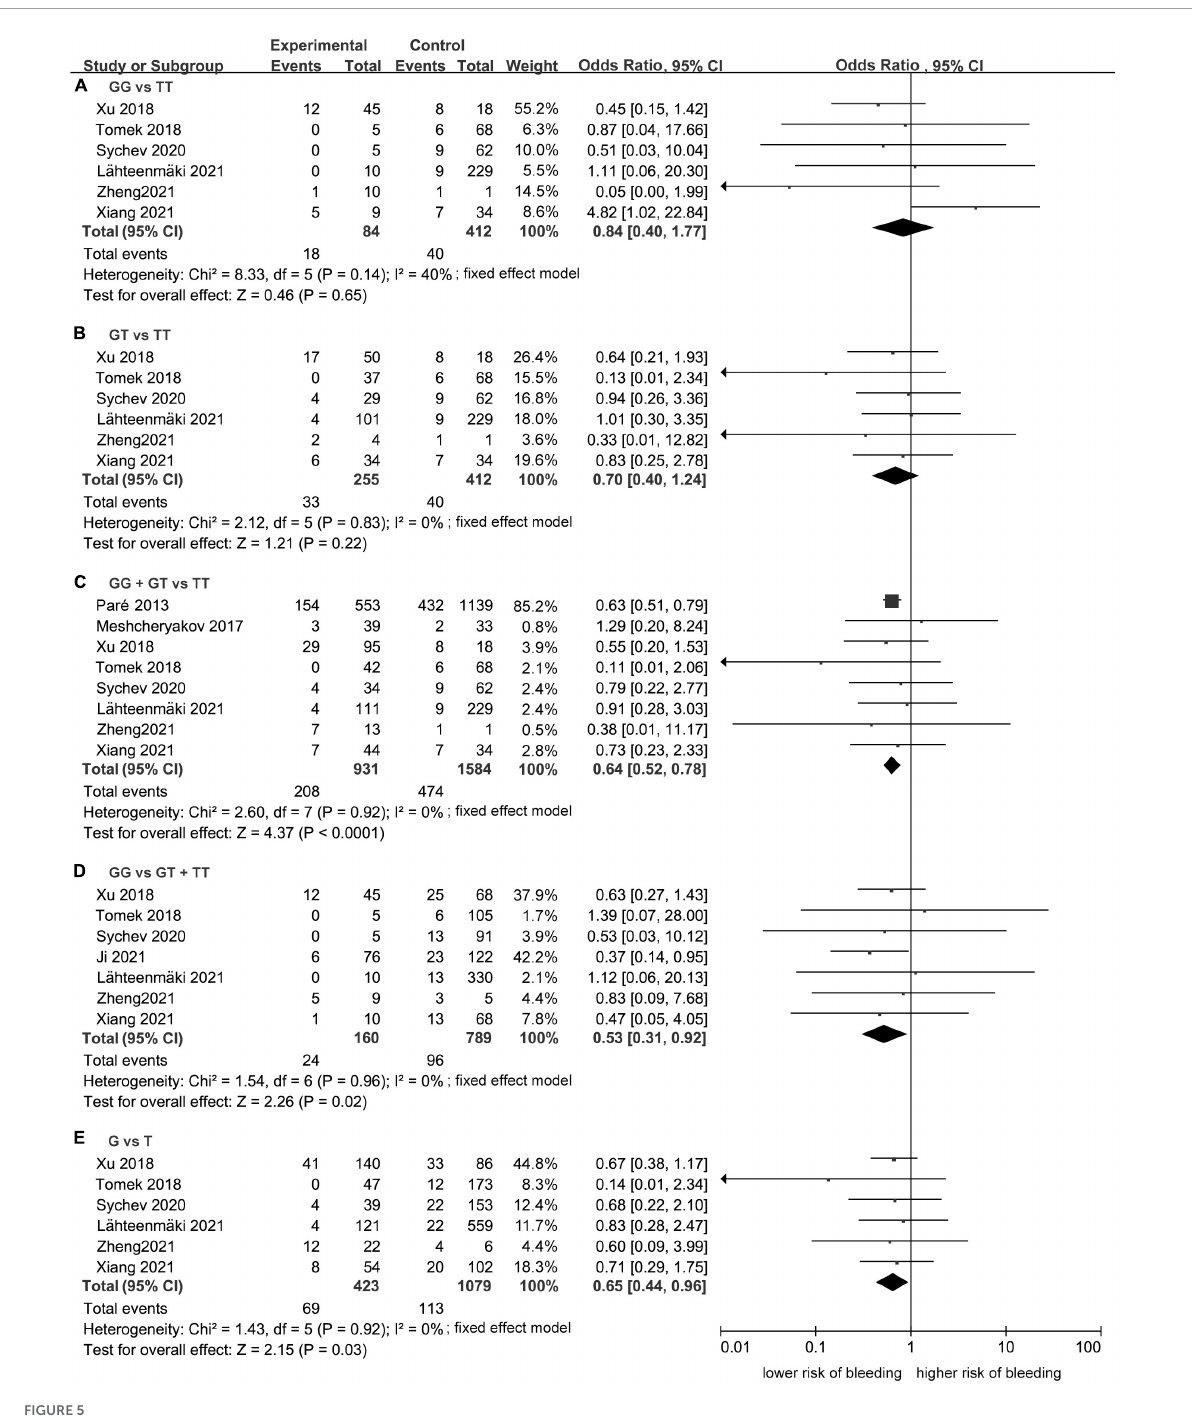
Mammalian CES belong to the α , β -hydrolase-fold protein superfamily, which can be divided into five categories in accordance with the homology of the amino acid sequences